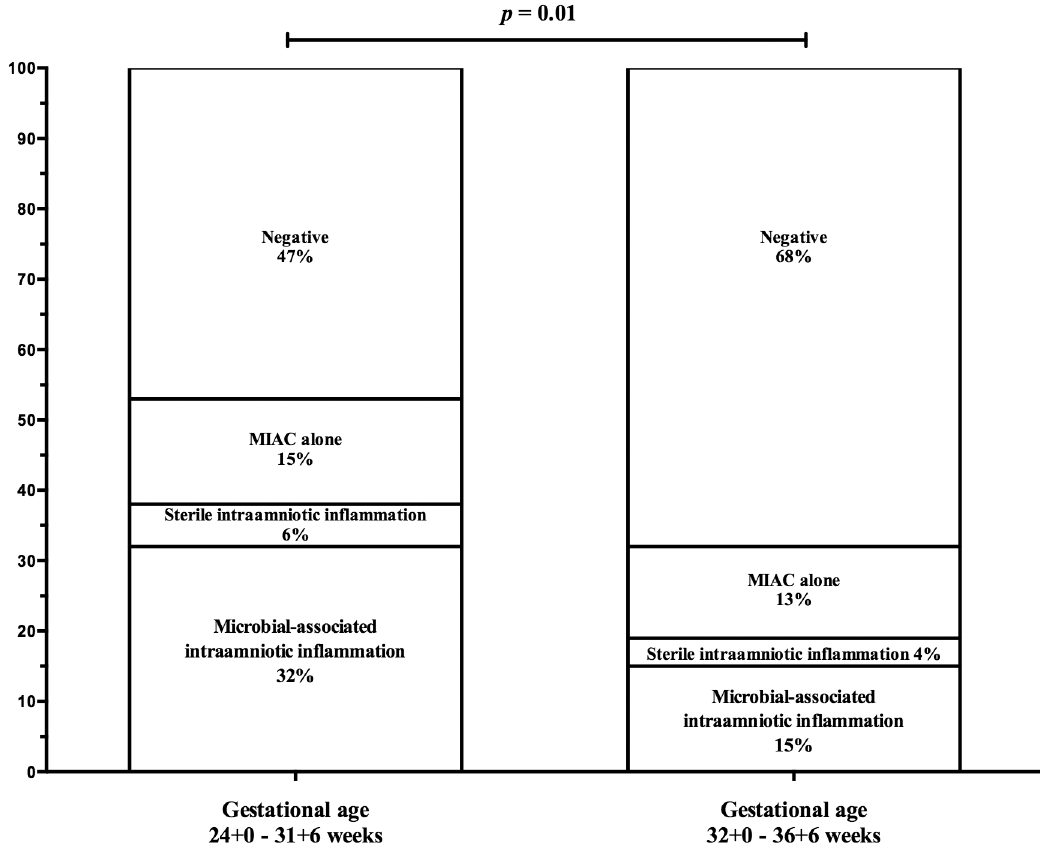
Fig 1. Prevalence of microbial-associated intraamniotic inflammation, sterile inflammation and microbial invasion of the amniotic cavity alone according to the gestational age at sampling.